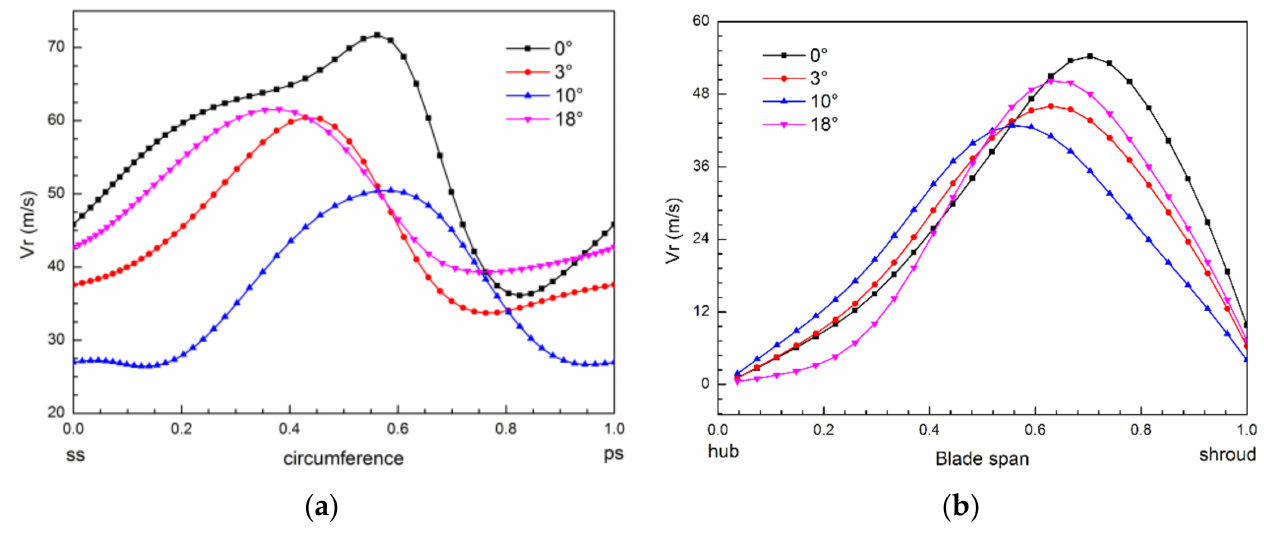
Figure 17. Radial velocity distribution at diffuser outlet. The minimum radial velocity at diffuser outlet is obtained by the 10 ◦ model. The most uniformed radial velocity at diffuser outlet is obtained by the 10 ◦ model. ( a ) Circumferential direction; ( b ) Blade spanwise